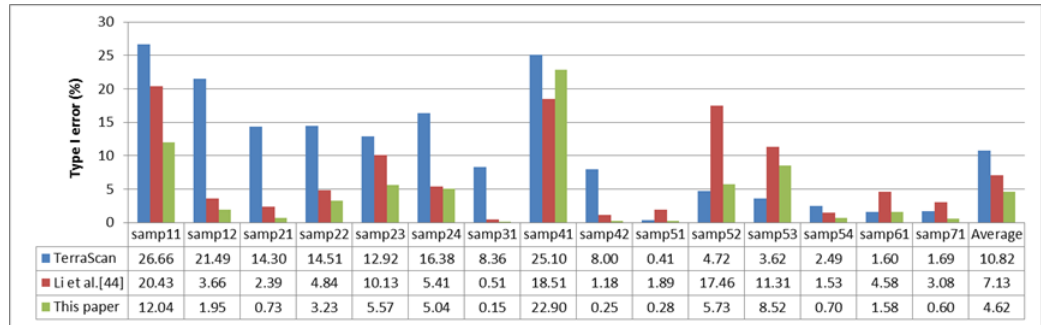
Figure 7. Comparison of type I errors for filtering the International Society for Photogrammetry and Remote Sensing (ISPRS) datasets.